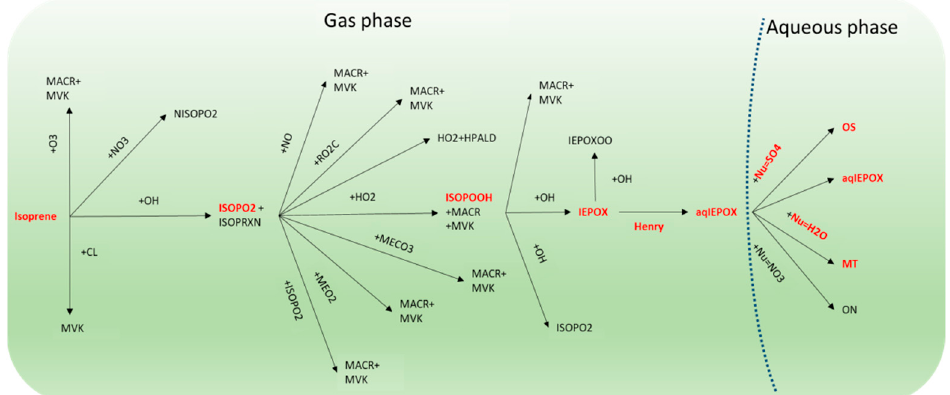
Figure 1. Isoprene epoxydiol organic aerosol (IEPOX OA) formation mechanism as implemented in the latest version of the Community Multiscale Air Quality (CMAQ) model (Pye et al. 2013). OS, MT and ON stand for organosulphates, methyltetrols and organonitrates respectively.